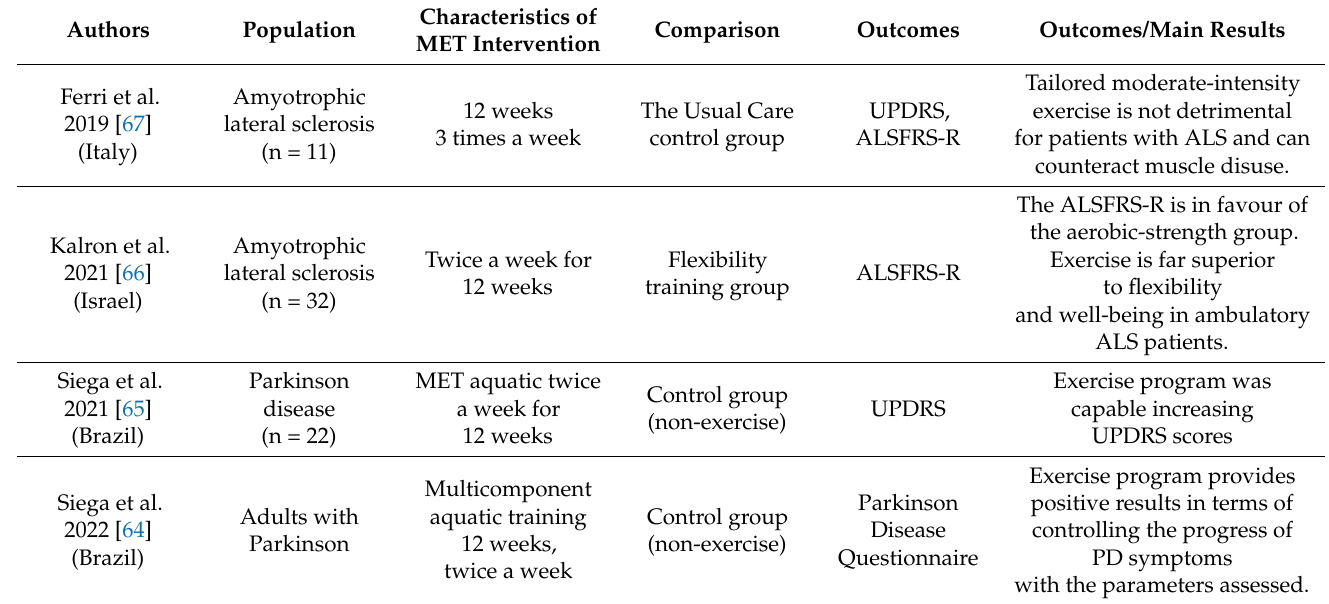
Table 4. Characterization of the excluded